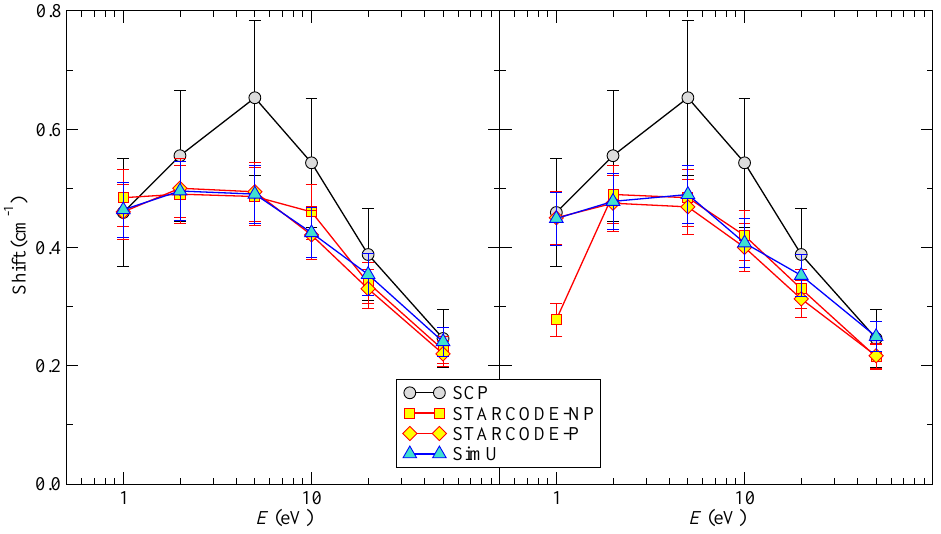
Figure 2. Li I 2 s − 2 p shift as a function of the energy E . ( Left ) the dipole interaction is only taken into account; ( Right ) the dipole and quadrupole interaction are both taken into